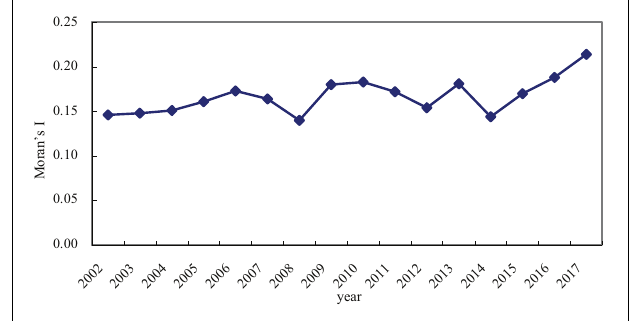
FIGURE 4 | Moran’s I index of the W-E-F-E nexus in Northwest